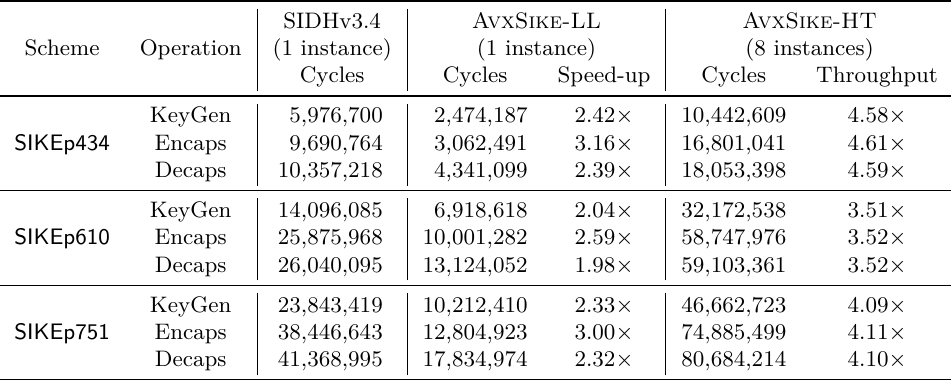
Table 6: Execution times (in cycles) of implementations of SIKEp434 , SIKEp610 , and SIKEp751 on an Intel Core i3-1005G1 processor. The cycle-counts for SIDHv3.4 and AvxSike-LL are for the execution of one instance of an operation and “Speed-up” is the speed-up factor compared to SIDHv3.4. The cycle-counts for AvxSike-HT are for the execution of eight instances of an operation and “Throughput” is the throughput gain compared to SIDHv3.4 when it executes eight